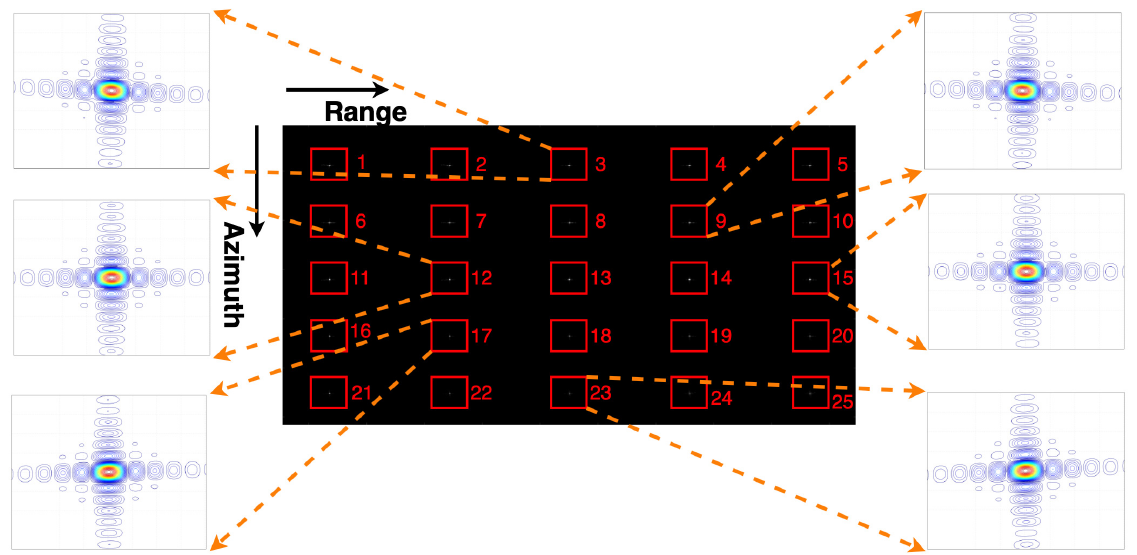
Figure 11. The imaging results of point targets for GTLR-BiSAR sliding spotlight mode. Table 2. PSLR, ISLR, and IRW of selected targets of SS mode in Figure 11 by the proposed method.